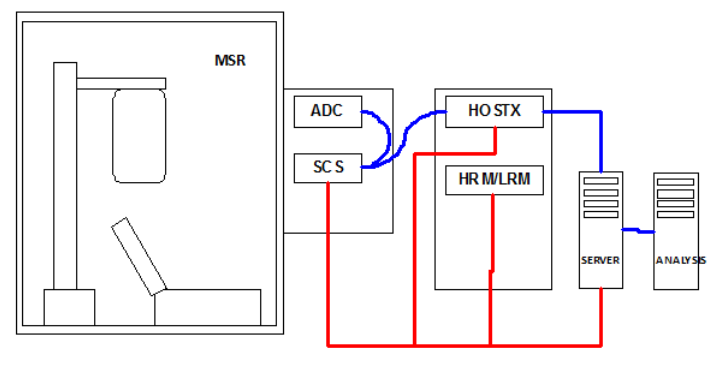
Figure 6. Block diagram of the MEG system. SCS is the sensor control system, PPS is the pre-processing system, HRM and LRM are, respectively, the high resolution monitor and the low resolution